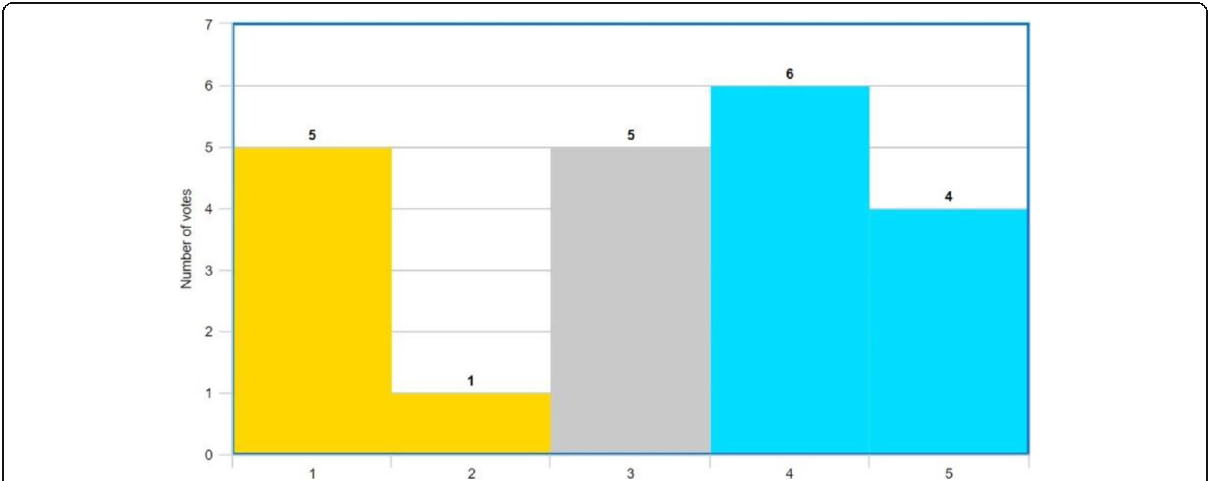
Fig. 8 Outcome of the survey question. The results show the 5-point Likert scale results (blue: favored the stabilized version; yellow: favored the original version; gray: neutral opinion)